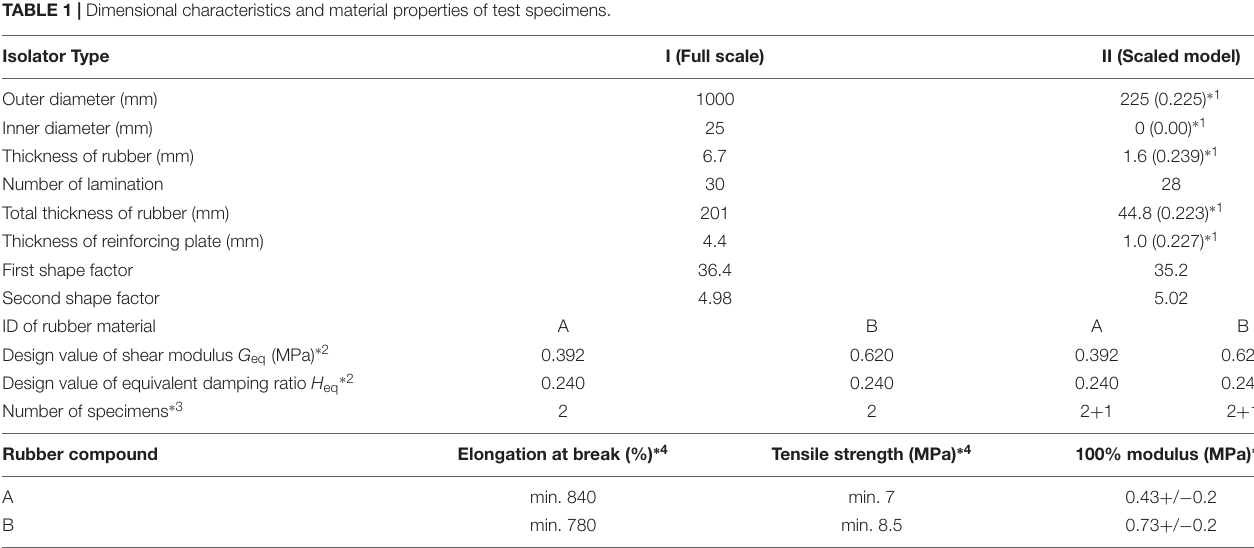
TABLE 1 | Dimensional characteristics and material properties of test